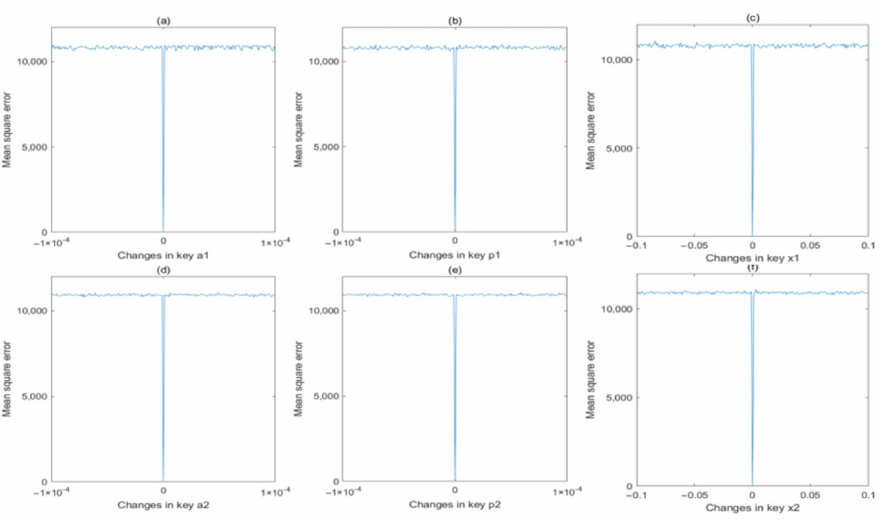
Figure 14. MSE analysis in encryption process for different keys: ( a ) a1; ( b ) p1; ( c ) x1; ( d ) a2; ( e ) p2; ( f ) x2.